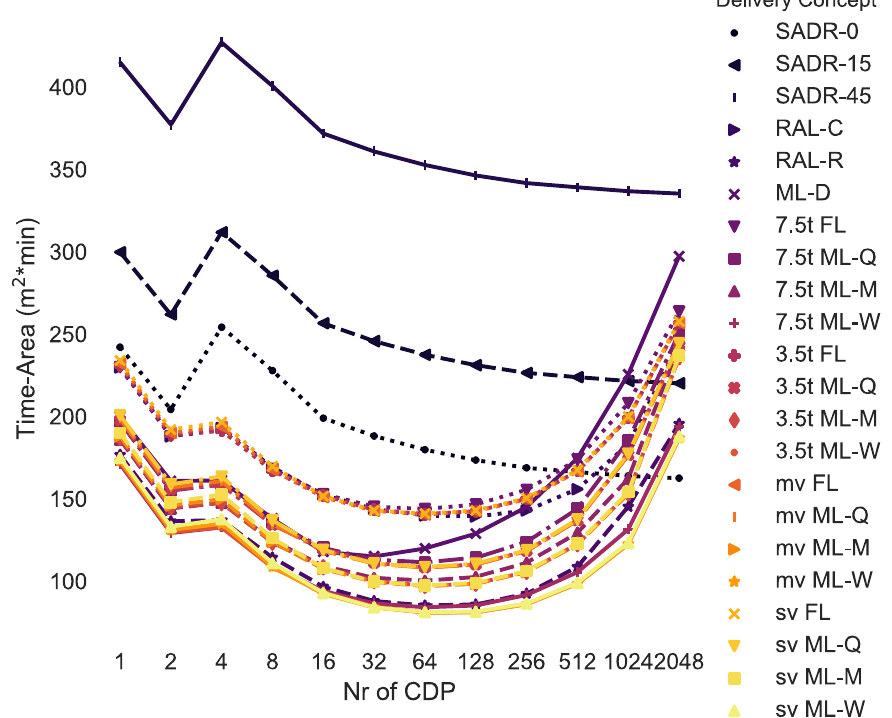
Figure 11. Time ‐ area requirements for all delivery concepts depending on the number of CDPs (den ‐ Figure 11. Time-area requirements for all delivery concepts depending on the number of CDPs sity: 1.0, customer: pedestrian). (density: 1.0, customer: